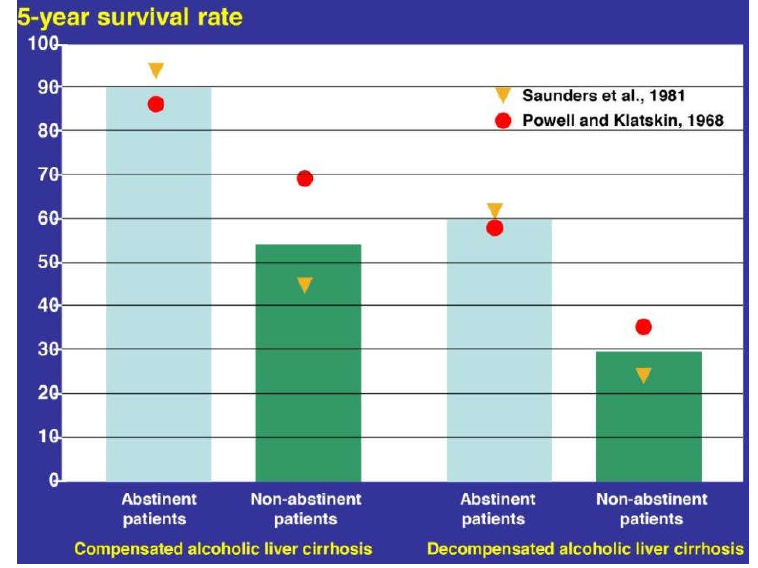
Figure 20. Prognosis of alcoholic cirrhosis. Shown is the 5‐year survival rate, prognosis is better in abstinent patients with compensated cirrhosis as compared to abstinent patients with decompensated cirrhosis. In both cohorts, continued alcohol use deteriorates the survival rate. The original figure was published in a previous report [341] and is reproduced with permission of the Publisher Wiley (Hoboken, NJ, USA).